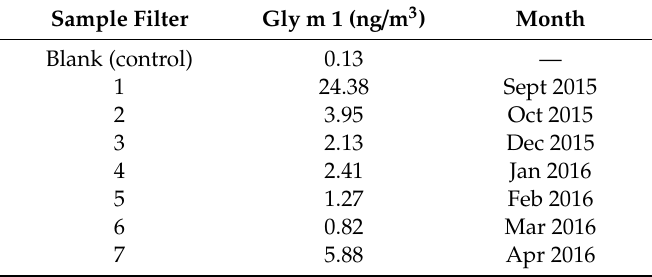
Table 1. Concentration of Gly m 1 in each monthly